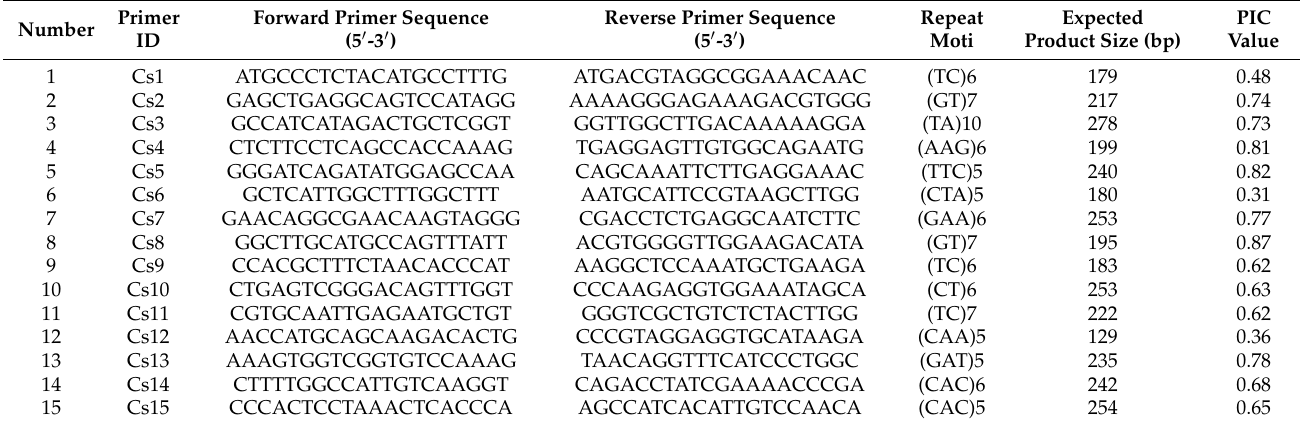
Table 3. Names and sequence information of the 15 SSR markers used for genetic